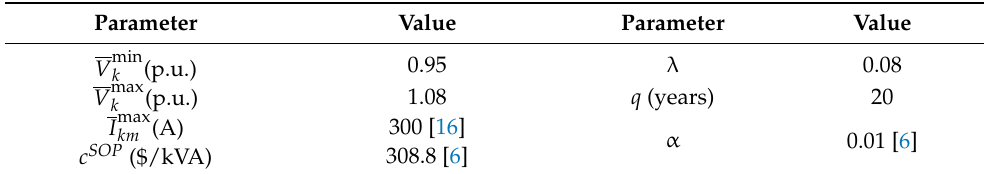
Table 3. General data and input